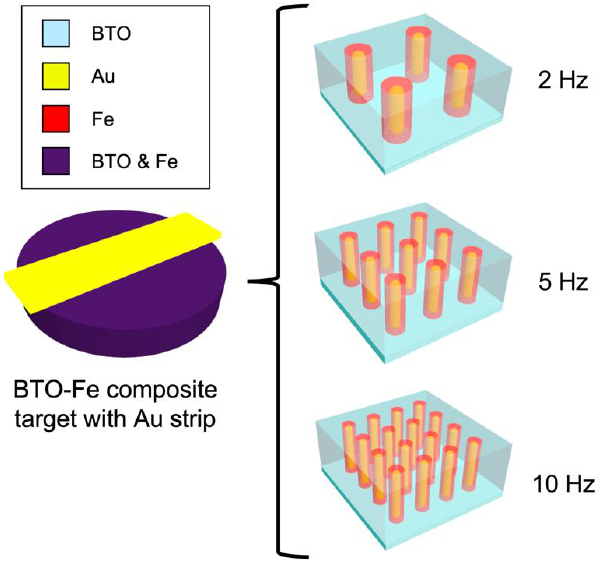
Figure 1. Predicted film fabrication at each deposition frequency based on using a single BTO-Fe target with an Au strip.